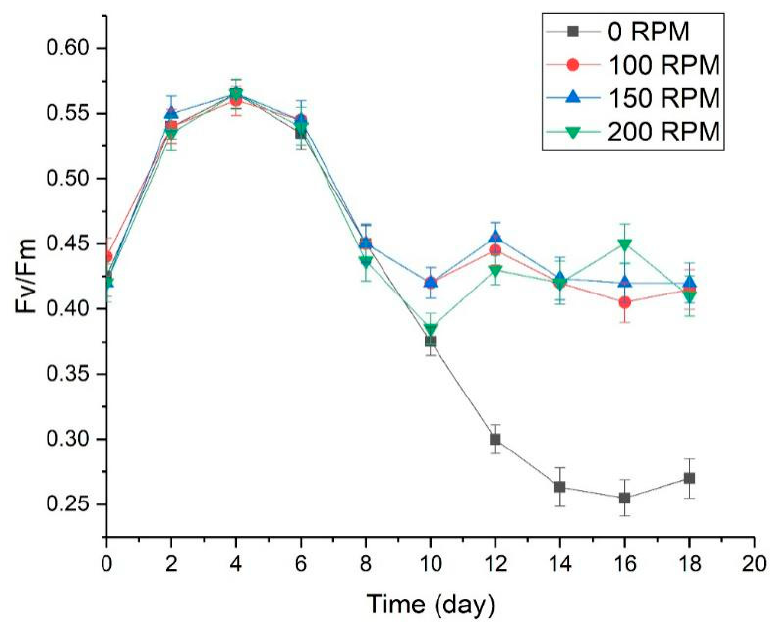
Figure 6. The chlorophyll fluorescence intensity of Microcystis aeruginosa under different turbulence conditions. Error bars represent the SD of triplicate samples.